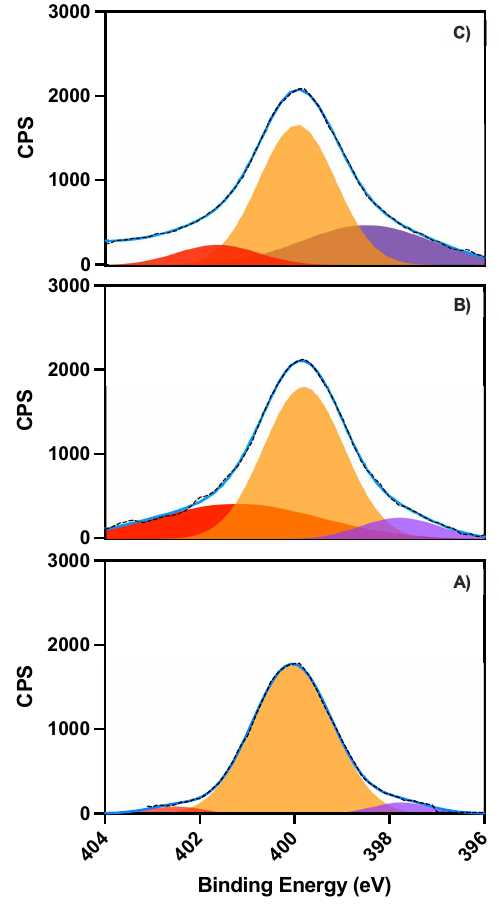
Figure 4. High resolution N1s XPS spectra; ( A ) ACA, ( B ) oxytocin-ACA, ( C ) O-NPs -oxytocin-ACA (CPS, counts per second).